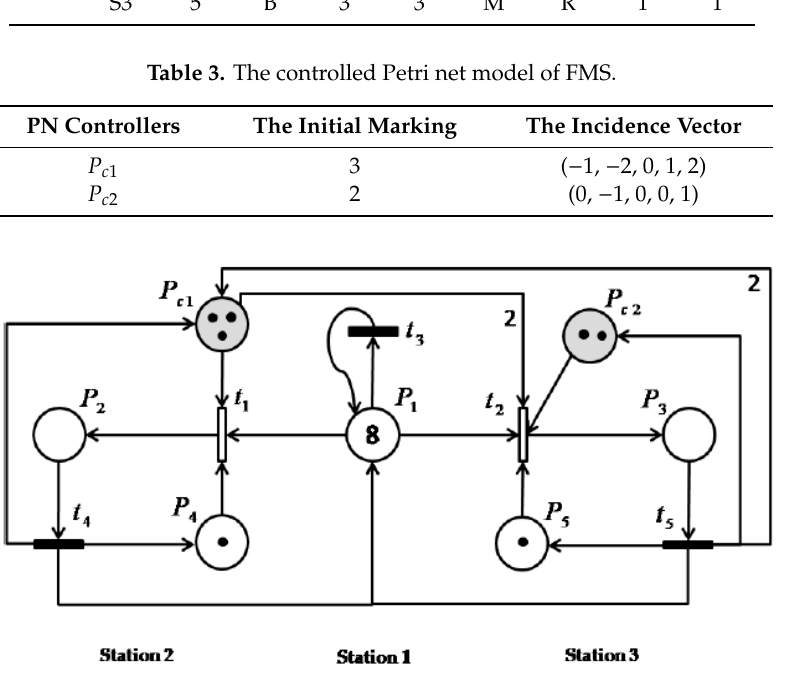
Figure 5. The controlled Petri net model of FMS.